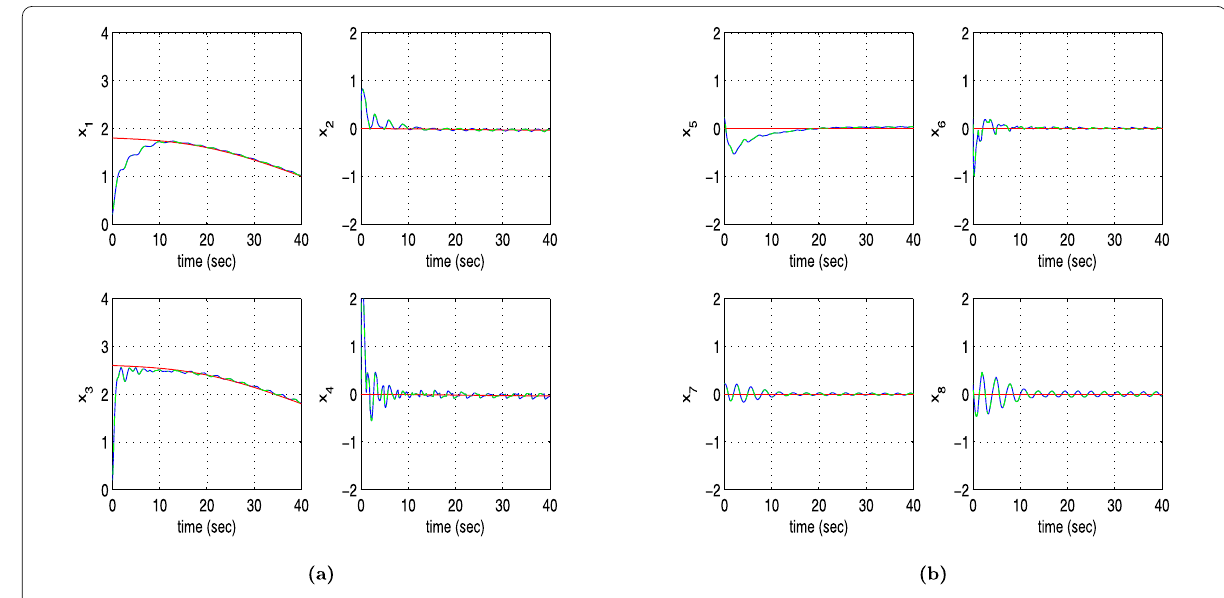
Figure 17 Tracking of setpoint 8 for the tower crane ( a ) convergence of state variables x 1 to x 4 to their reference setpoints (red line: setpoint, blue line: real value, green line: estimated value), ( b ) convergence of state variables x 5 to x 8 to their reference setpoints